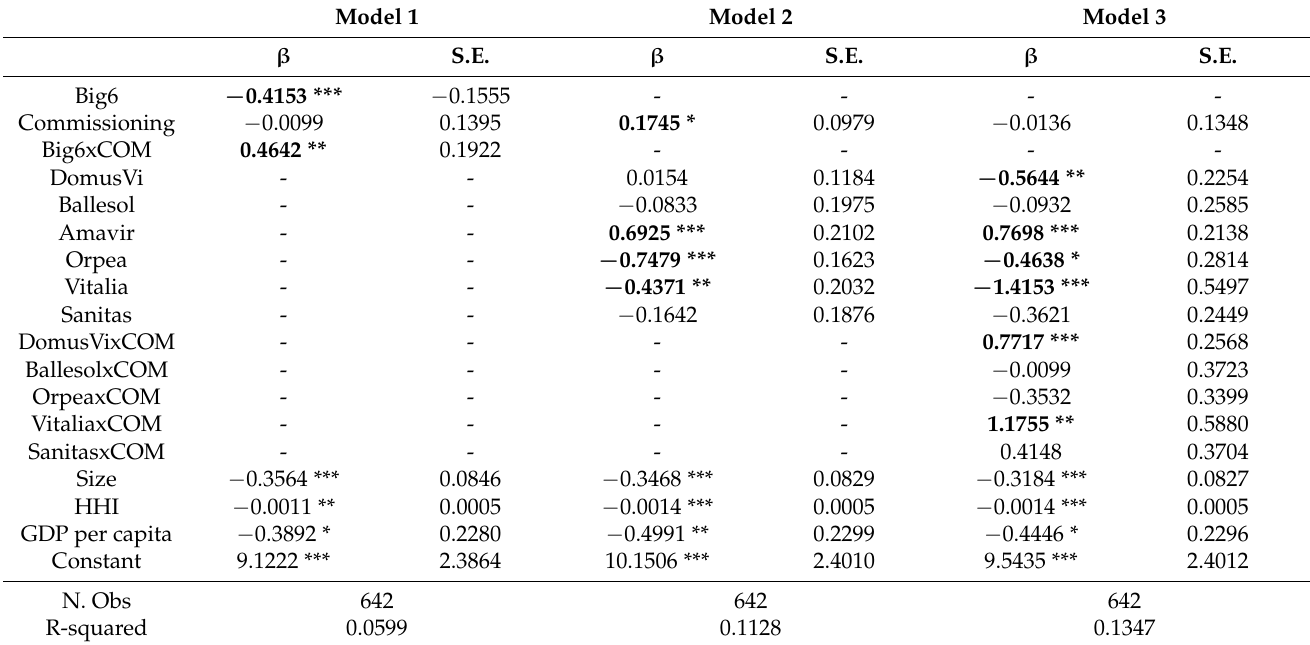
Table 4. Econometric